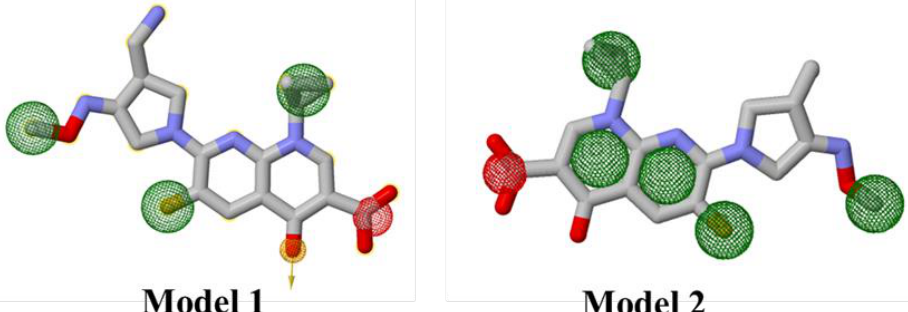
Figure 2. Representation of two gemifloxacin pharmacophore models. The green, red, and yellow color interlaces indicate the hydrophobic, negative ion charge, and hydrogen bond acceptor regions, respectively.